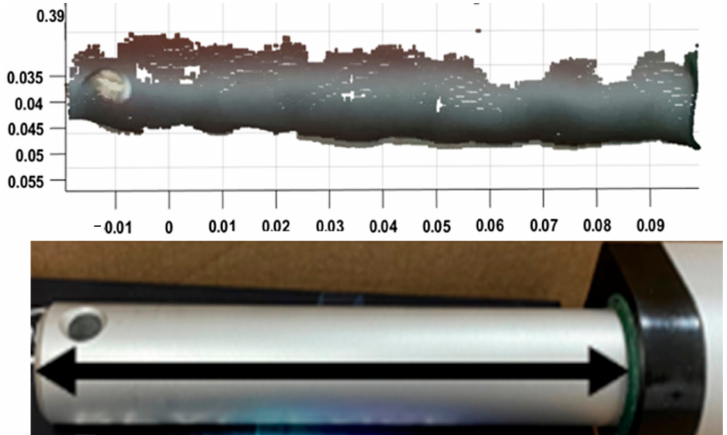
Figure 2. Point-cloud acquisition output of the piston in its extended configuration and corresponding RGB